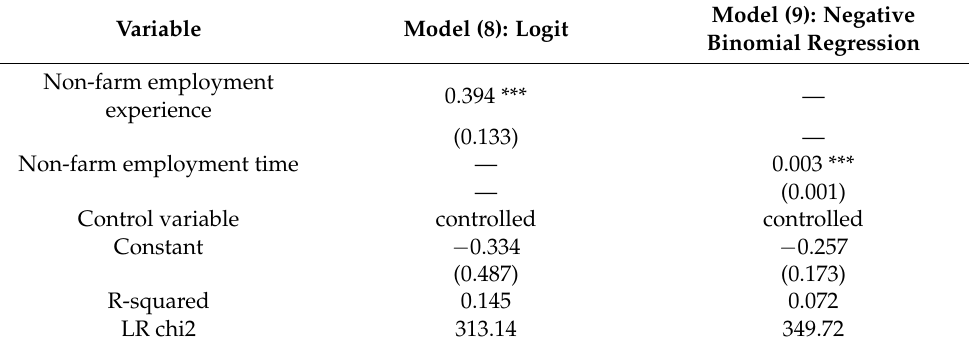
Table 5. Robustness test.